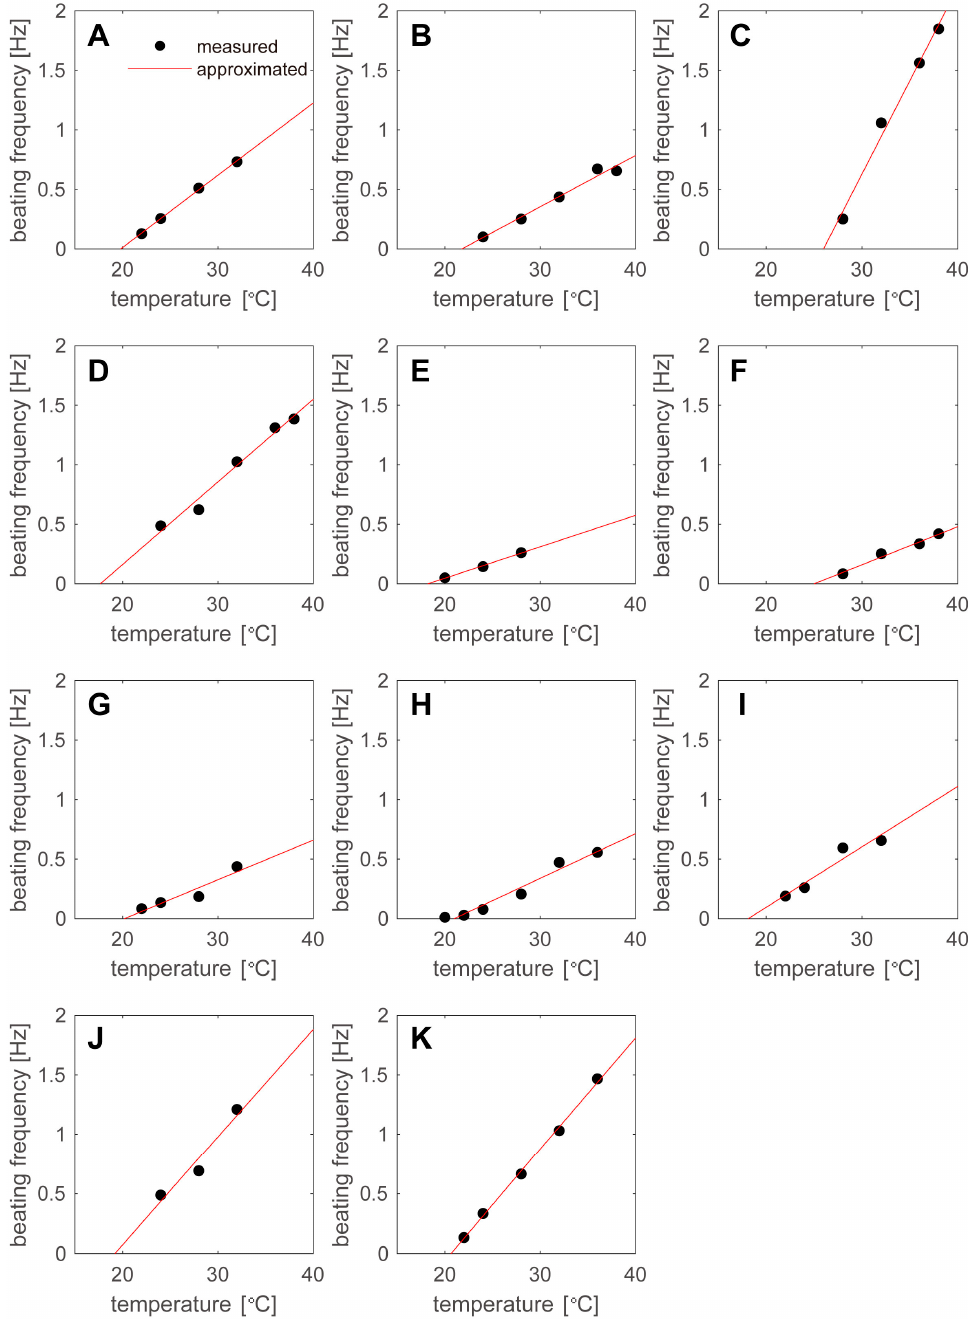
Figure 7. Relationship between temperature and beating frequency. In any hiPSC-CMs, there is a linear relationship between the temperature T ( ◦ C) and beating frequency f (Hz). ( A – K ) The relationships between temperature and beating frequency for cell groups A to K,